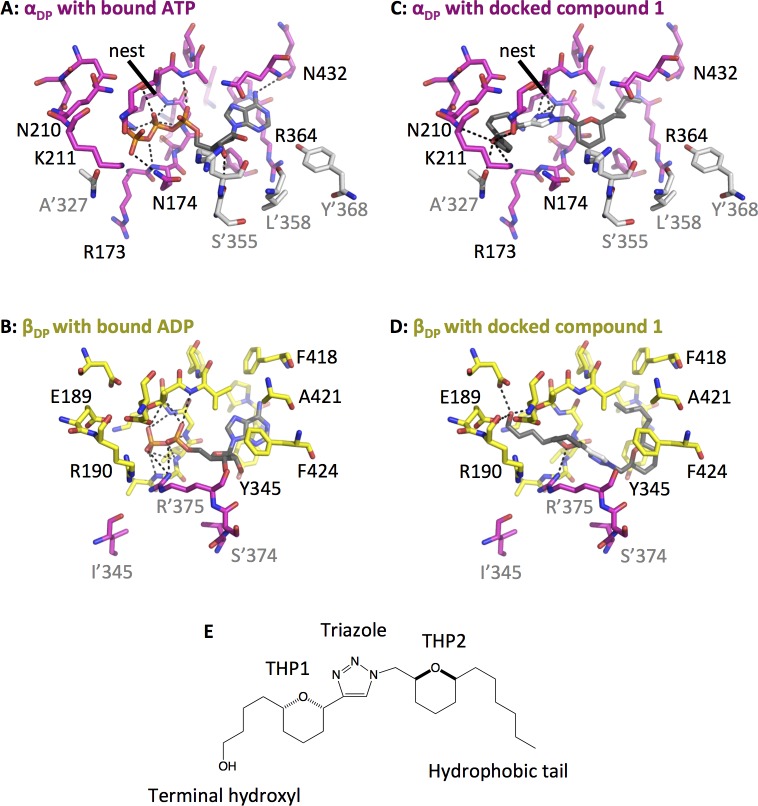
Binding of nucleotide and compound 1 to yeast F1 α- and β-subunits.Yeast F1 subunits are oriented around the Walker A motif for comparisons. (A and B) The crystal structure yeast F1 with bound nucleotide (PDB entry 2WPD [68]). ATP occupies that regulatory site of the α-subunit (A), while ADP occupies the catalytic site of the β-subunit (B). The positioning of nucleotide is similar for both: the adenine anchors within a hydrophobic pocket while the phosphates interact with the Walker A nest. Hydrogen bonds are shown as dotted lines. (C-D) Docking of compound 1 into the yeast ATP binding sites. In the regulatory α-subunit (C) the triazole moiety of compound 1 interacts with the Walker A nest, THP2 occupies the position of the nucleotide ribose, the hydrophobic tail buries into the hydrophobic adenine pocket, and the terminal hydroxyl forms extensive H-bonds. The position is compound 1 is different in β-subunit (D), whereby THP2 is sandwiched between Tyr345 and Phe424, the hydrophobic tail buries into the adenine site, and THP1 and terminal hydroxyl form potential H-bonds. (E) Compound 1.